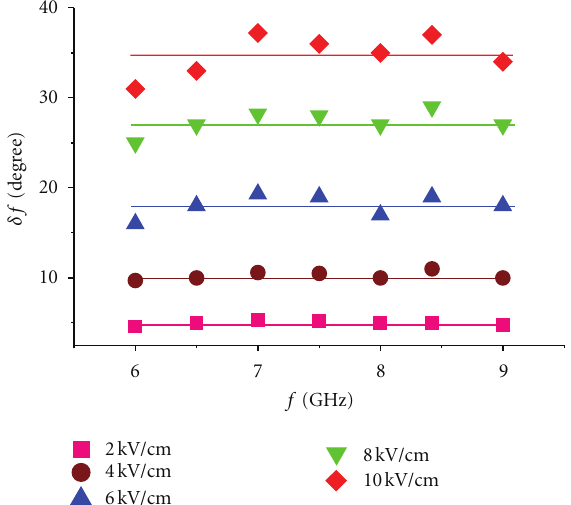
Figure 11: Di ff erential phase shift versus frequency at di ff erent electric field E . H is parallel to sample L = − 3 / 4dB; YIG 26.8 μ m; φ = 4mm; t GGG = 440 μ m; PMN-PT 0.5mm; φ = 6mm.